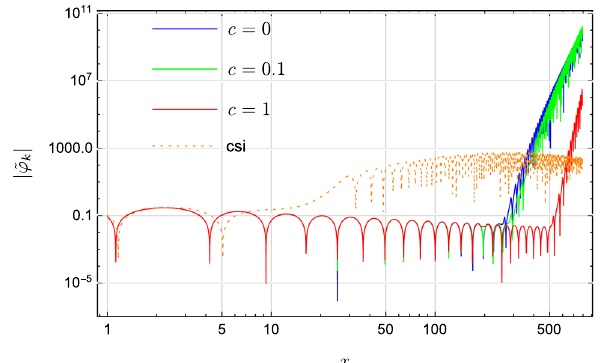
potential. Figure 4 shows the time evolution of ˜ ϕ k for dif- ˜ k during RD (up) and MD (bottom), ferent wavenumbers ˜ V is given by Eq. (3) with c = 0. The modes with when ˜ ˜ k = 10 − 1 / 2 got slightly enhanced just after k = 10 − 1 and the onset of the oscillation due to the tachyonic